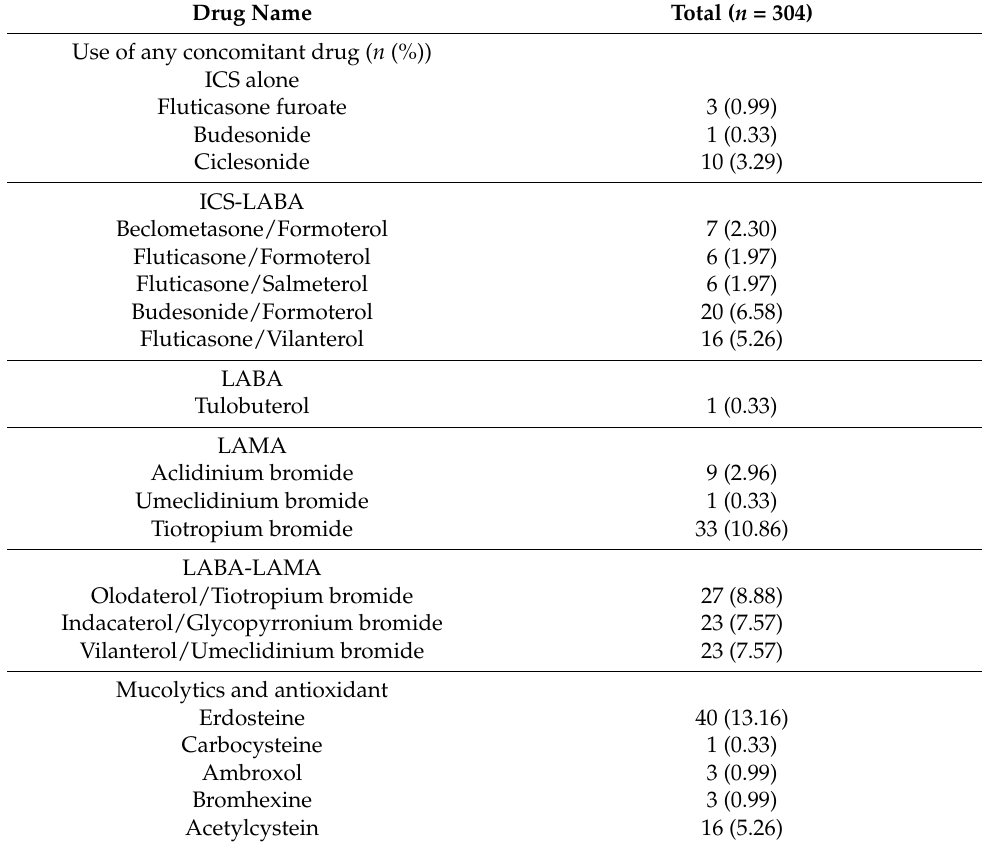
Table 2. Pharmacologic treatment for chronic bronchitis and bronchiectasis at